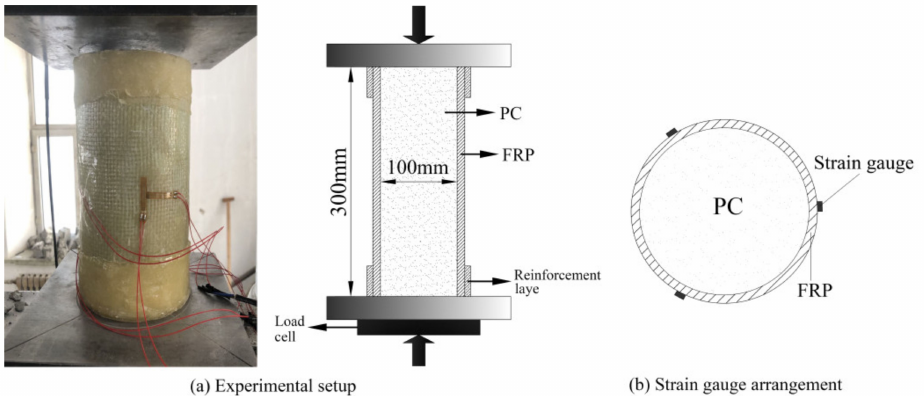
Figure 3. Loading device and strain